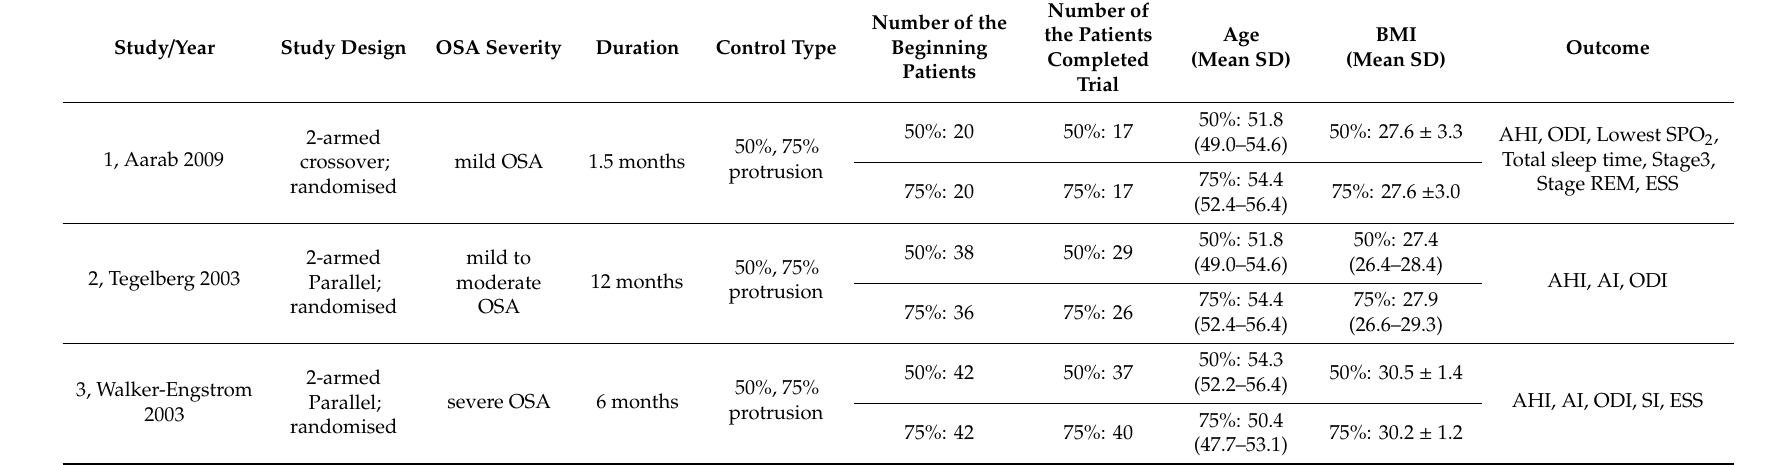
Table 1. Characteristics of the included